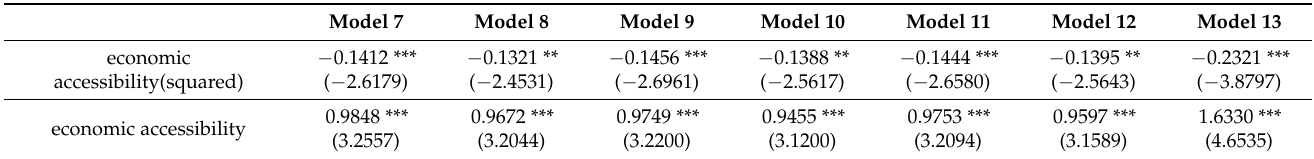
Table 3. The moderating role of family